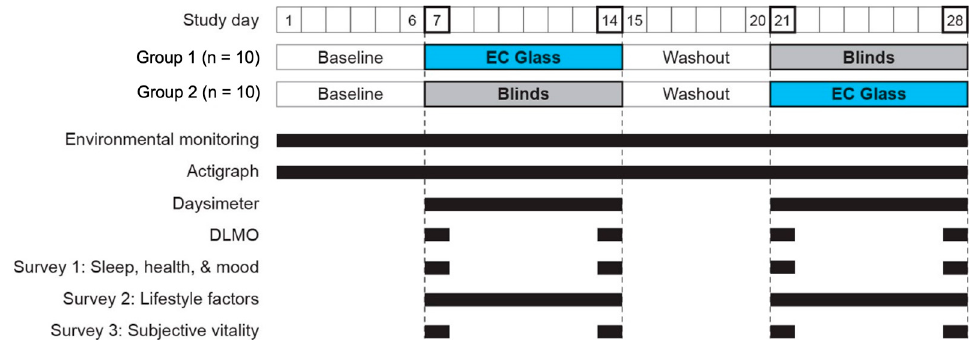
Figure 2. The study protocol, showing the schedule for delivery of the two experimental conditions and data collection for environmental conditions, objective sleep (actigraph), rest-activity and personal light exposures (Daysimeter), biospecimen collection for DLMO, and the three surveys. DLMO and subjective vitality (SVS data) were collected every 4 h on the first and last days of the intervention periods (shown in